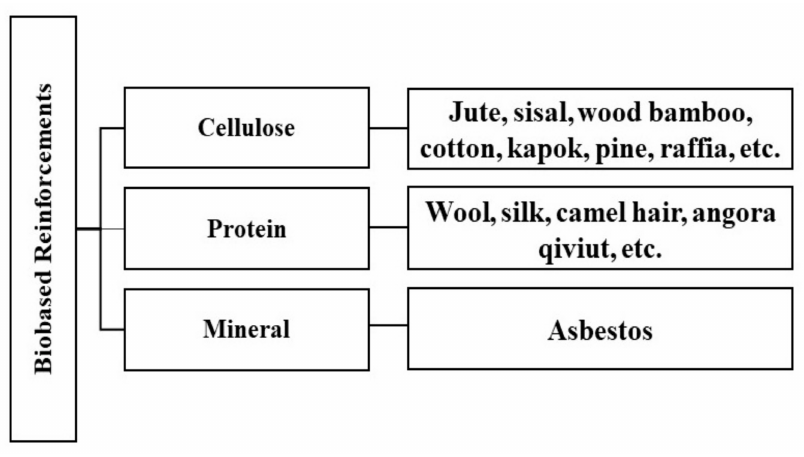
Figure 12. Biobased reinforcement materials for